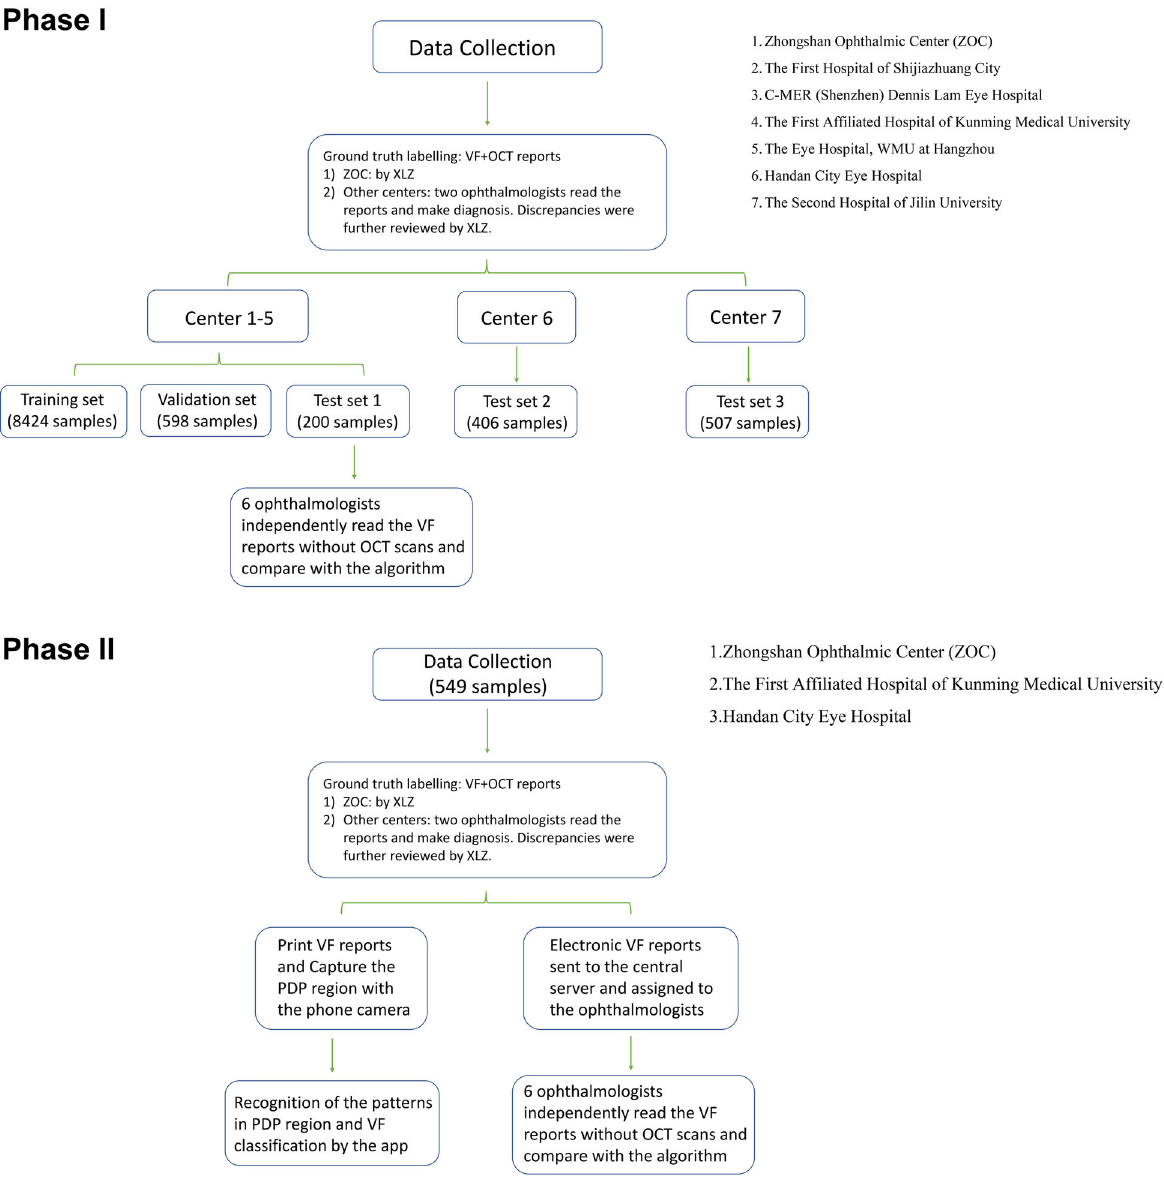
Fig. 3 Flow chart of the current study. The study is composed of two parts. In Phase I, we developed the deep learning algorithms for classifying VFs. In Phase II, a smartphone app based on the deep learning algorithm was created and tested in the real